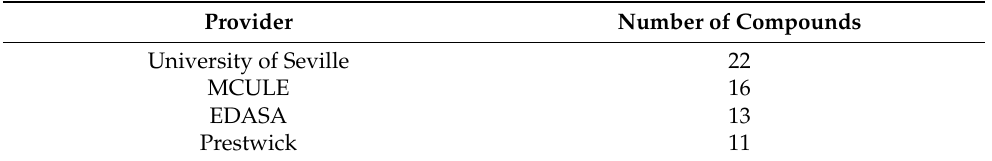
Table 1. The number of in silico screening hit compounds that were obtained from each provider after visual inspection of the top-score docking binding